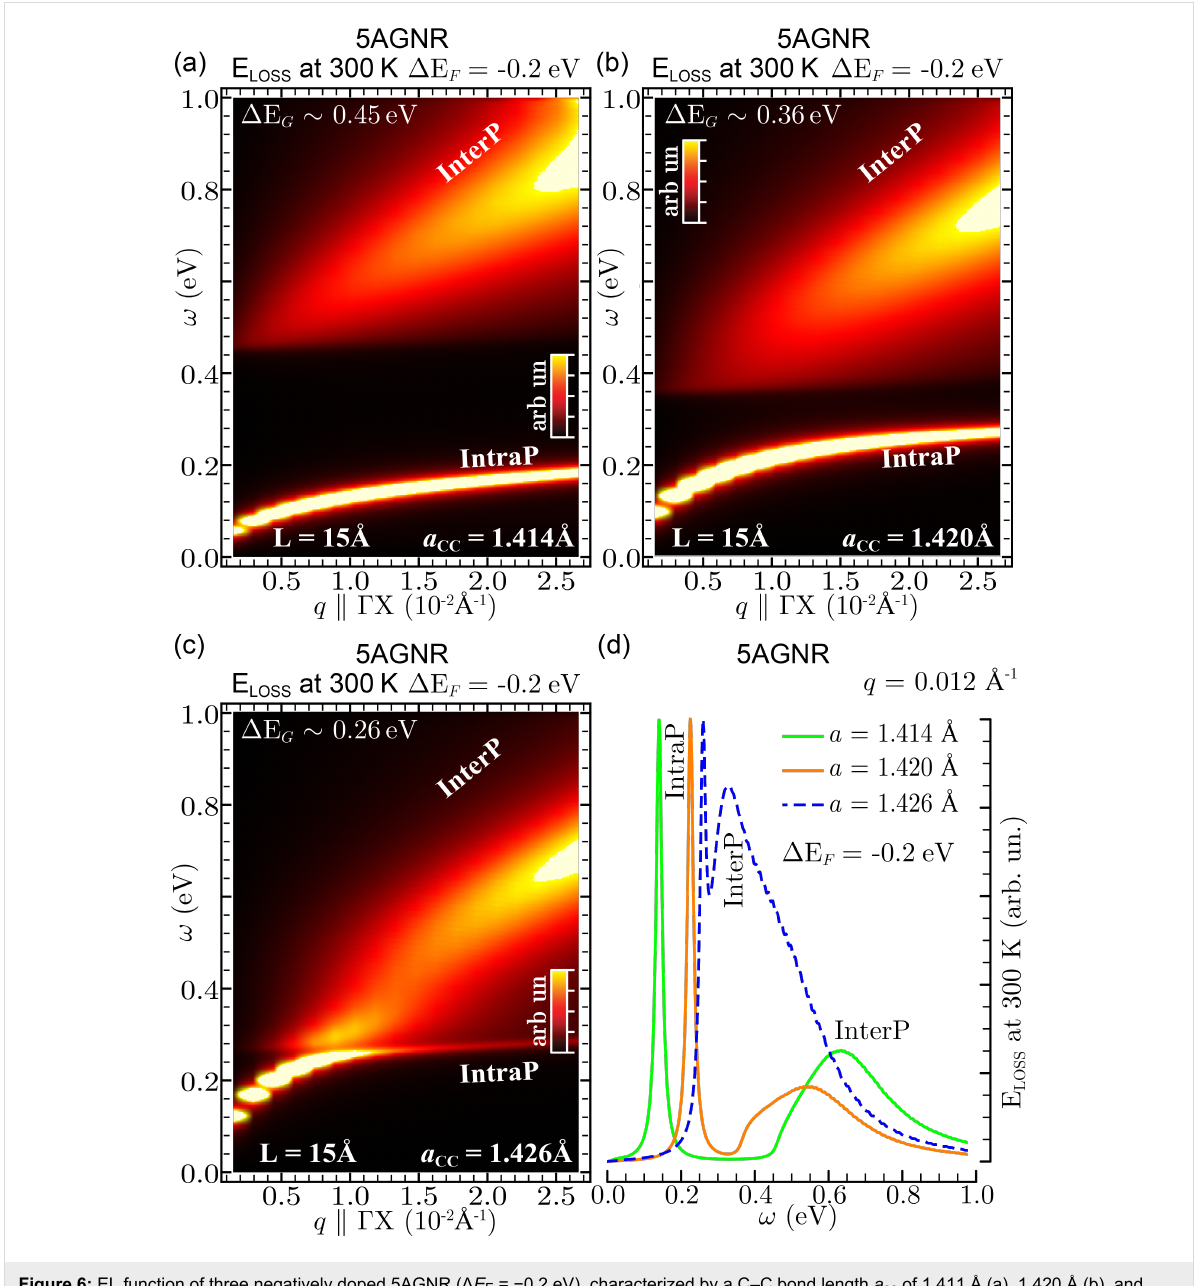
Figure 6: EL function of three negatively doped 5AGNR ( Δ E F = − 0.2 eV), characterized by a C–C bond length a cc of 1.411 Å (a), 1.420 Å (b), and 1.426 Å (c), which correspond, respectively, to the band gap values Δ E G = 0.45 eV (a), 0.36 eV (b), 0.26 eV (c). In (a–c), the energy–momentum region ω ≤ 1 eV and q || Γ X ≤ 0.03 Å − 1 is explored, showing that a cc (or the lattice constant 3 a cc ) is a major factor in modulating the intraband and interband plasmons, denoted IntraP and InterP as in Figures 2–5. The intensity scale is cut at 40% of the IntraP peak. The effect of stretching